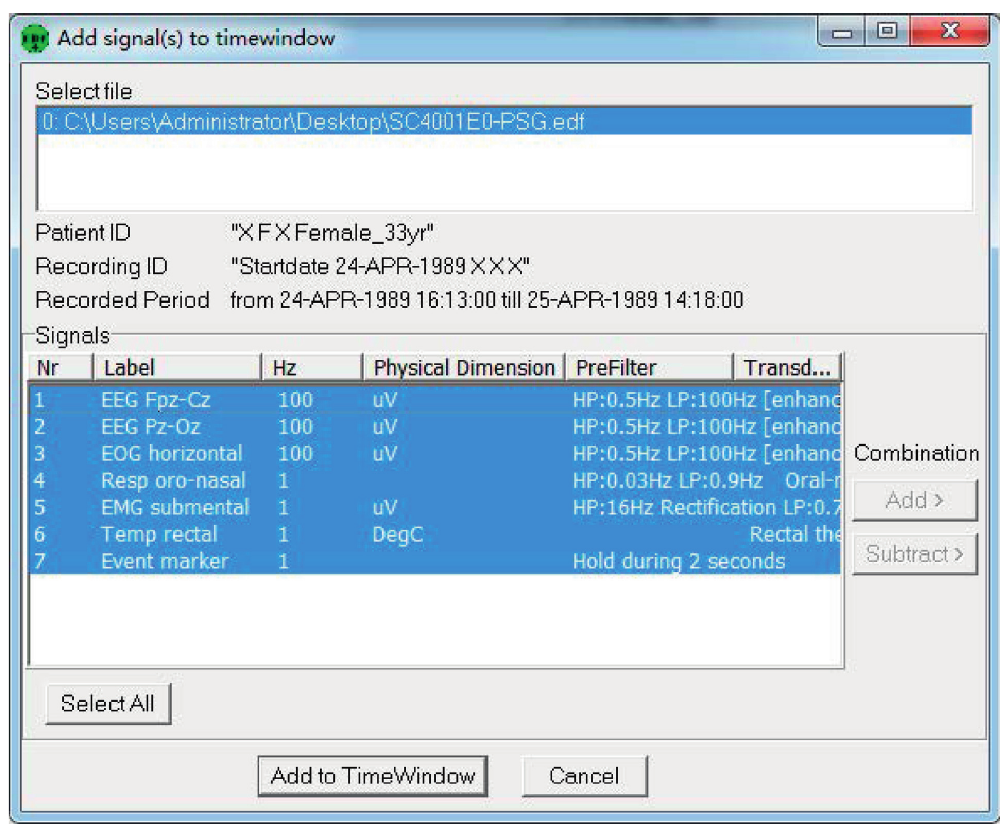
Figure 5: The features extracted such as horizontal EOG, Fpz-Cz, and